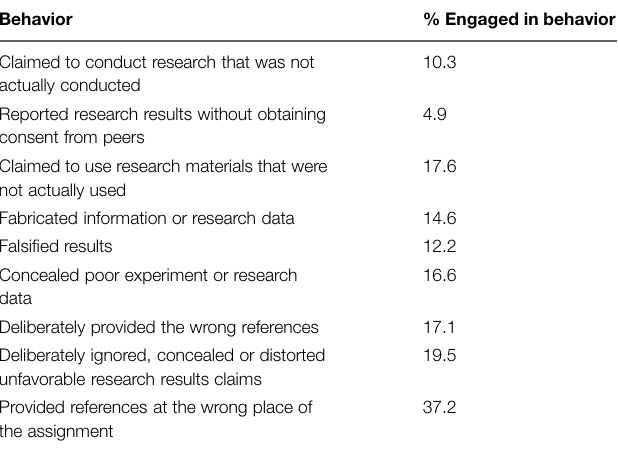
TABLE 2 | Percentage of participants self-reporting engaging in research